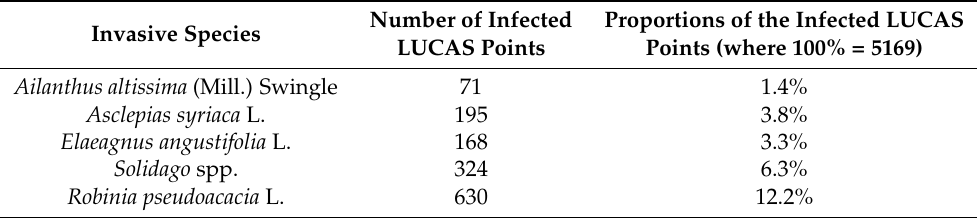
Table 1. Number and proportion of invasive plants surveyed at LUCAS field monitoring points.